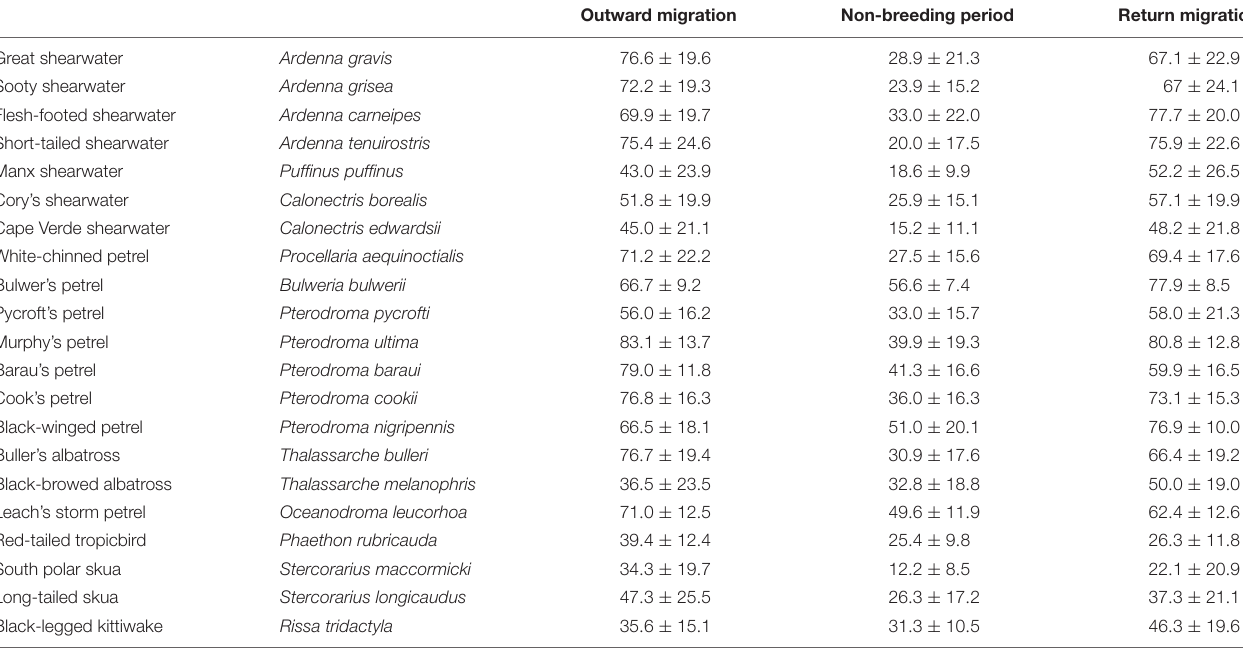
TABLE 1 | Mean ( ± SD) percentage of time spent in flight during each migratory stage for different seabird species. Outward migration Non-breeding period Return migration